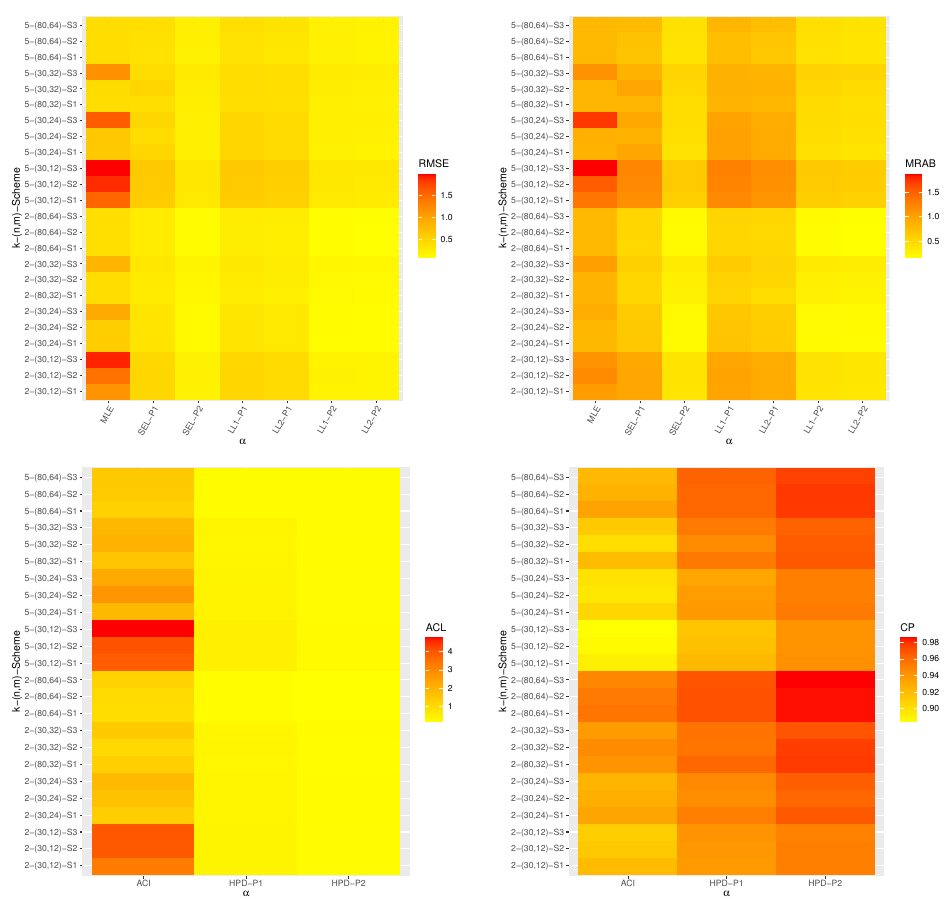
Figure 1. Heatmap plots for classical and Bayesian estimation results of α